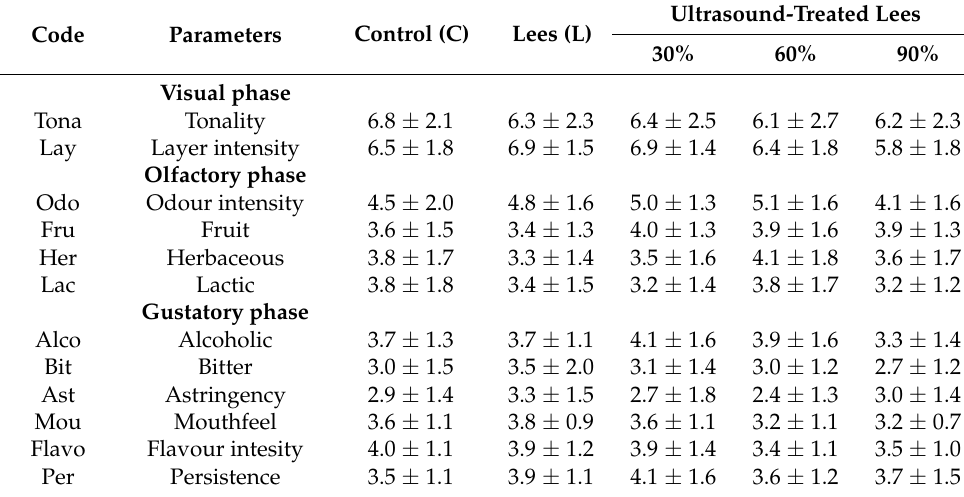
Table 3. Sensory evaluation of the wines aged on ultrasound-treated and untreated